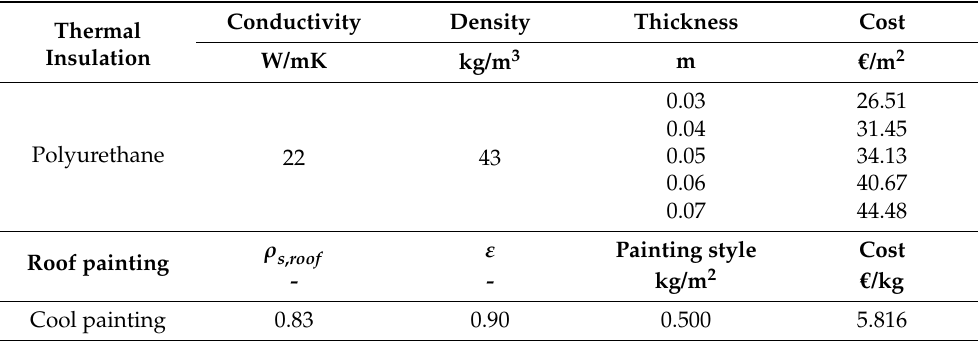
Table 8. Thermal insulation [40] and cool pain [30] technical specifications and cost figures.